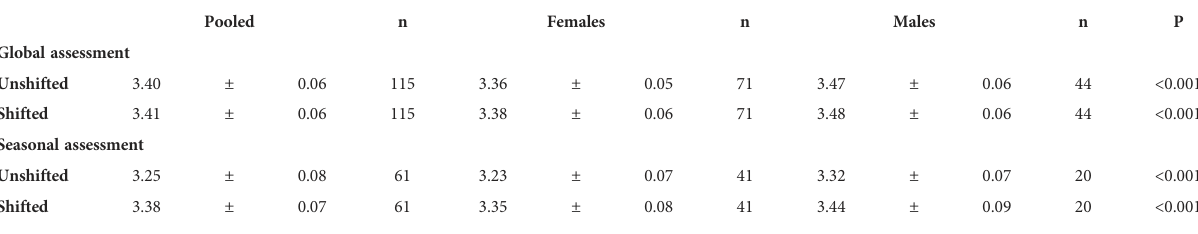
TABLE 2 Trophic position (mean ± sd) in Syngnathus acus specimens collected in 2017 and 2018 in C ı ́ es Archipelago. Pooled n Females n Males n